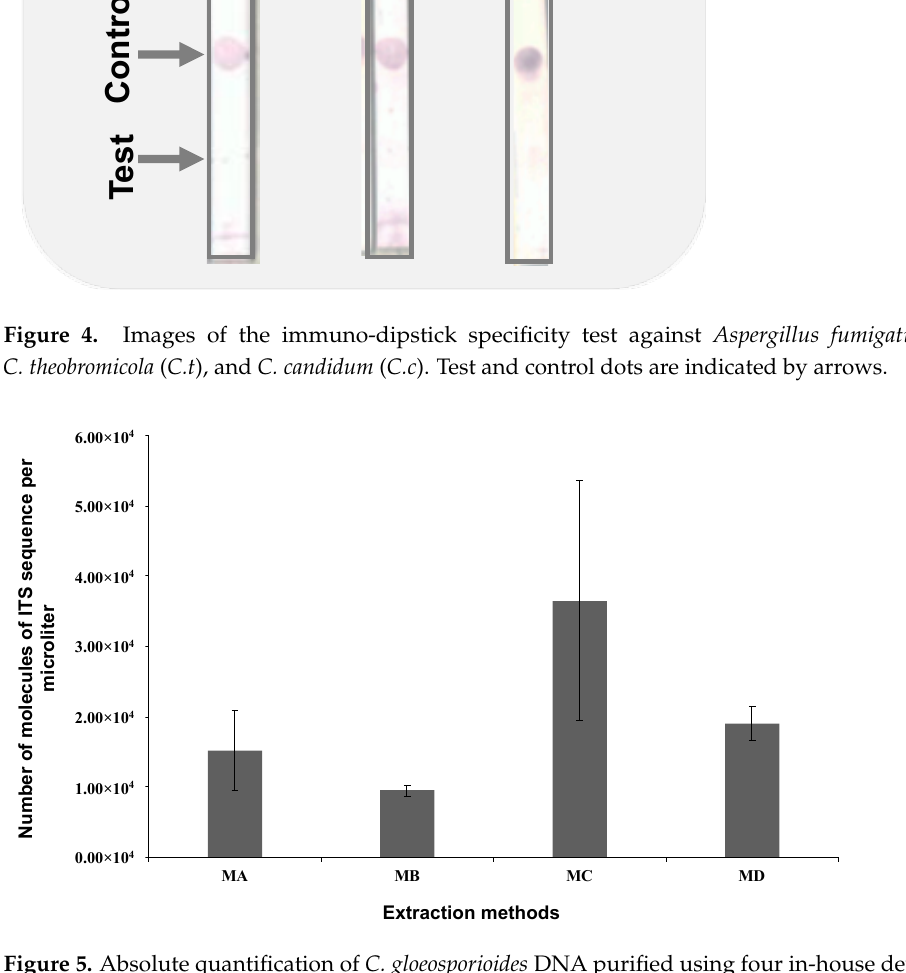
Figure 4. Images of the immuno-dipstick specificity test against Aspergillus fumigatus ( A.f ), C. theo- bromicola ( C.t ), and C. candidum ( C.c ). Test and control dots are indicated by arrows.